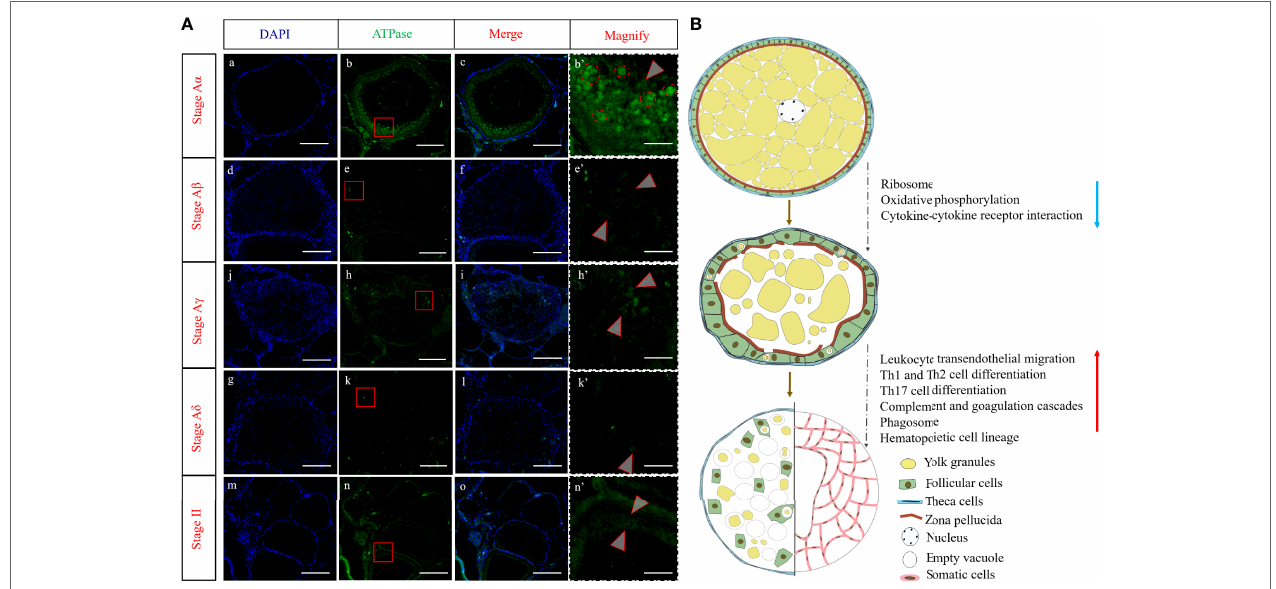
FIGURE 9 | (A) Fluorescence immunohistochemistry analysis of ATPase in five stages of follicular atresia. The b’, e’, h’, k’, and n’ are enlarged images of red boxed regions in b, e, h, k, and n, respectively. Arrows indicate the ATPase signals. The red dashed line circles in b’ represent vitellin with autofluorescence. (B) A schematic model illustrating the molecular changes in follicle atresia. Scale bar = 400 μm (a–o), 70 um